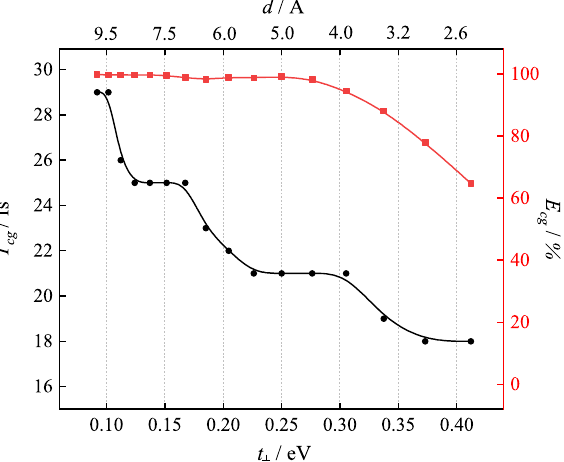
Figure 4. The dependence of charge generation time and efficiency on the intermolecular coupling (distance) in the organic molecular array.